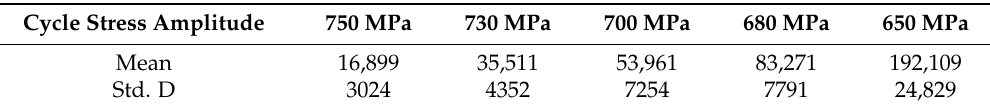
Table 3. Mean and standard deviations (Std. D) of fatigue life of the first group (tempering temperature 500 ◦ C).